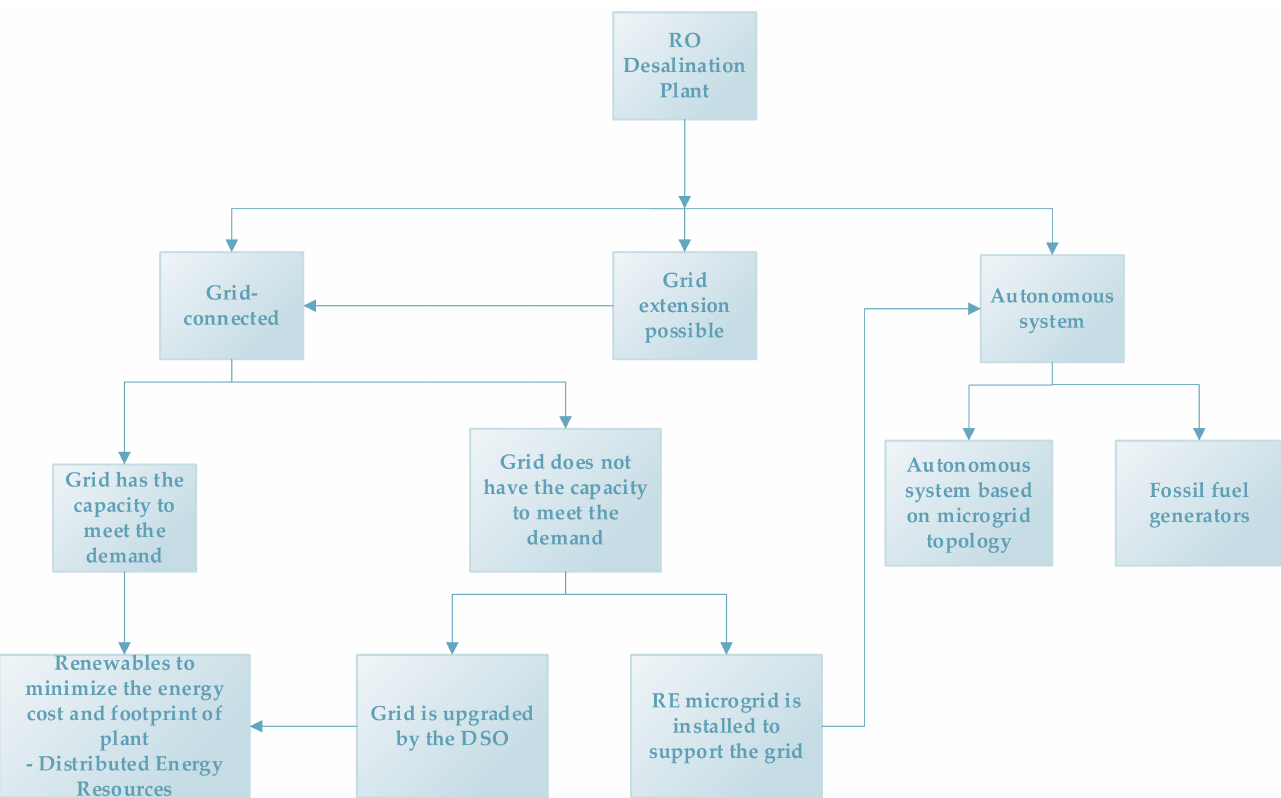
Figure 2. Powering RO